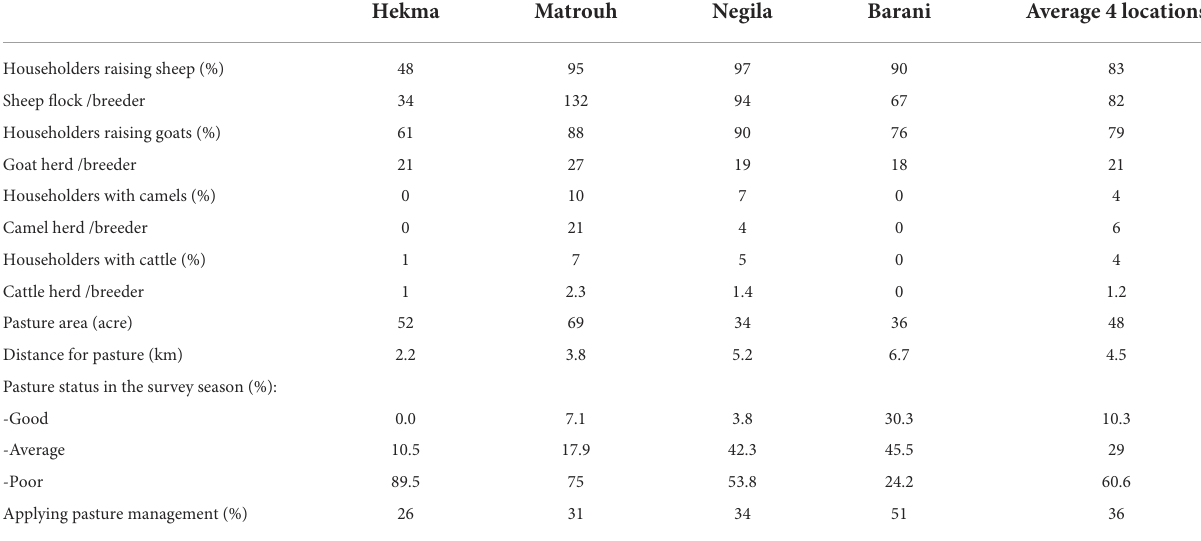
TABLE 1 Livestock production for householders. Hekma Matrouh Negila Barani